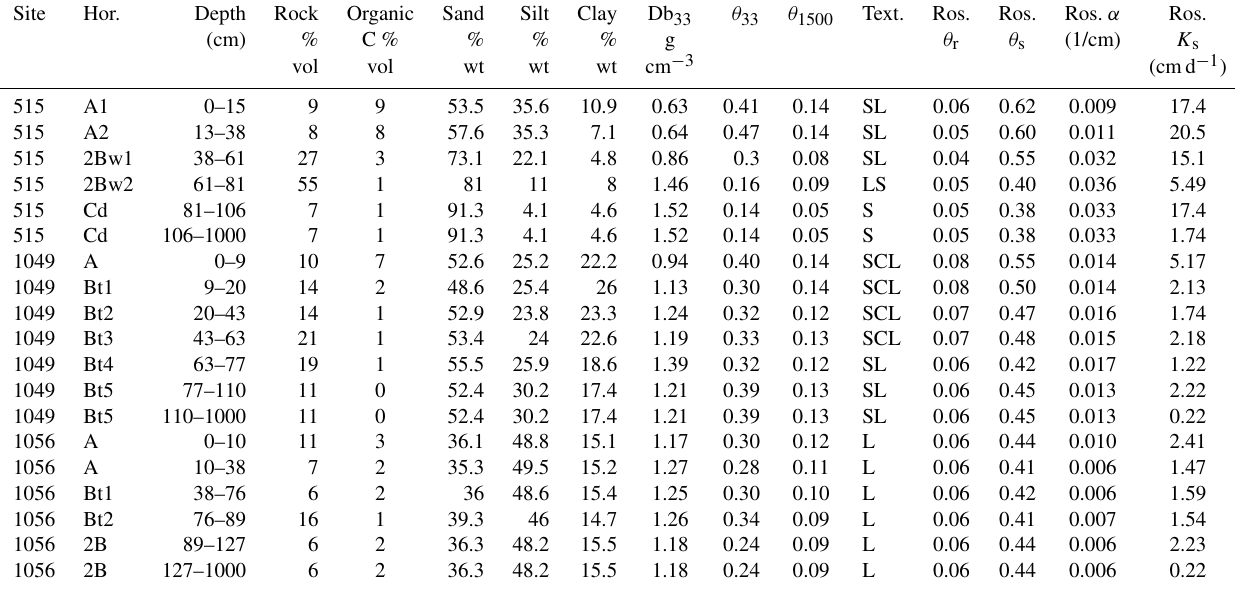
Table 2. Soil profile properties derived from NRCS pedon reports and the ROSETTA (Ros.) neural network. Columns are SNOTEL site, soil profile horizon, depth range of horizon, rock percent of sample volume, organic carbon percent of sample volume, sand percent of sample weight, silt percent of sample weight, clay percent of sample weight, Db 33 bulk density of soil sample desorbed to 33kPa, θ 33 volumetric water content at field capacity, θ 1500 volumetric water content at wilting point, soil texture, residual volumetric water content θ r , saturated volumetric water content θ s , pore size distribution parameter α , and K s saturated hydraulic conductivity. The lowest horizon K s